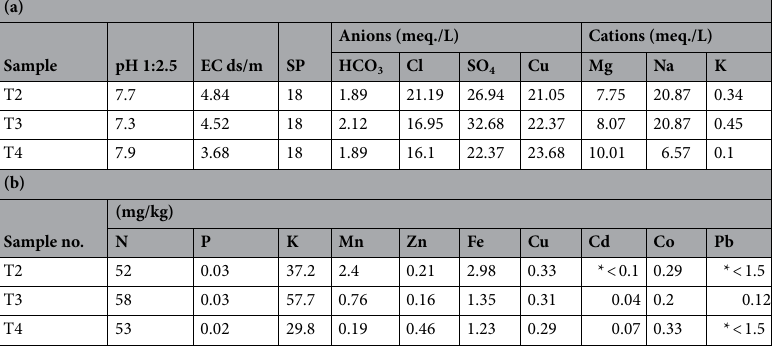
Table 3. (a): Chemical analysis of field sand samples, (b): Available macro, micronutrients, and heavy metals content of the sand samples. *Detection Limit (μg/kg). T2 October, T3 Benu Suef location, T4 Fayoum, SP Saturation percentage, EC electrical conductivity, HCO 3 hydrogen carbonate, SO 4 sulfate, Cl chloride, Cu copper, Mg magnesium, Na sodium, K potassium, N nitrogen, Fe iron, Mn manganese, Pd lead, Co cobalt, P phosphorus, Zn zinc, Cd cadmium.